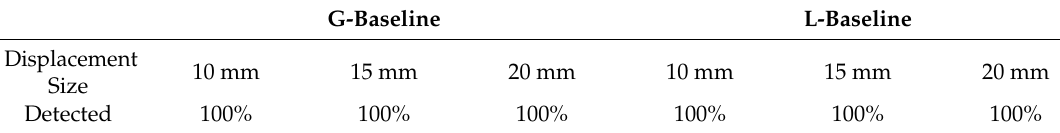
Table 9. Detection of 2D displacements.